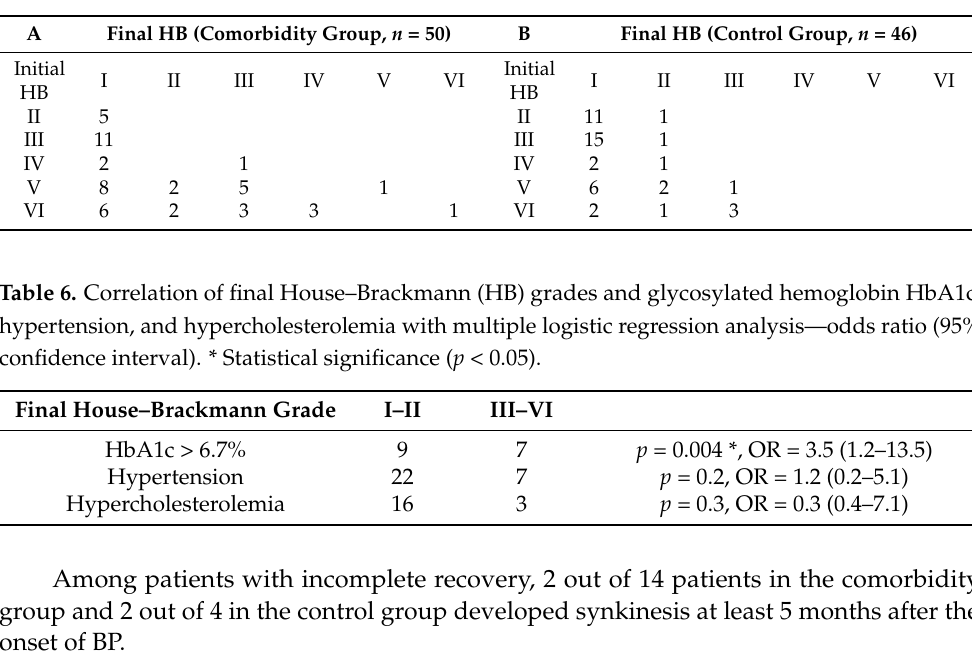
Table 5. Recovery distribution of facial function in Bell’s palsy to the different House–Brackmann (HB) grades (A) in the study group (comorbid diseases: diabetes mellitus, hypertension, and hyperc- holesterolemia) and (B) in the control group.